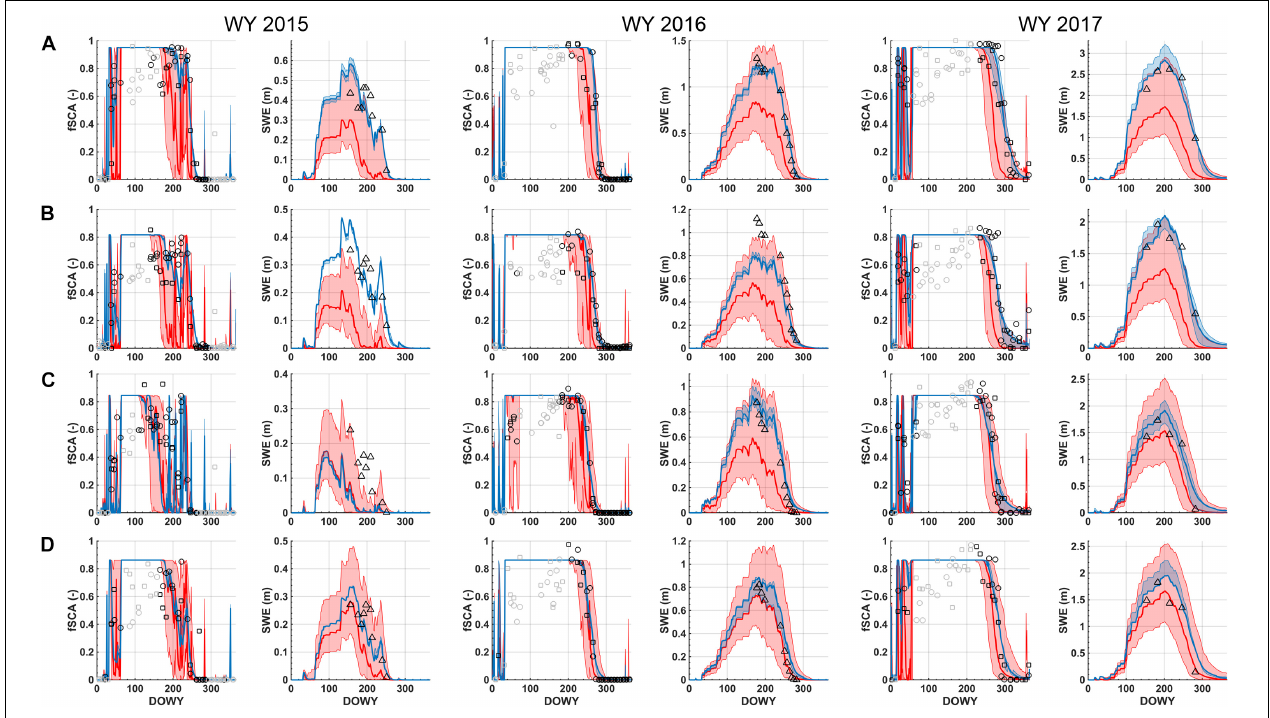
FIGURE 7 | (A) Prior (red) and posterior (blue) predicted fSCA and grid-averaged SWE for each WY corresponding to location #1 shown in Figure 1 . The ensemble estimates are represented by the: median (solid line) and inter-quartile range (shaded region). Assimilated fSCA measurements are shown as open circles (Landsat) and CDF-matched MODSCAG (open squares). The fSCA measurements shown in gray are those that do not contribute to the update (since the prior ensemble spread is zero). The independent ASO SWE estimates are shown as open triangles. Panels (B–D) are the same but for location #2 to #4 shown in Figure 1